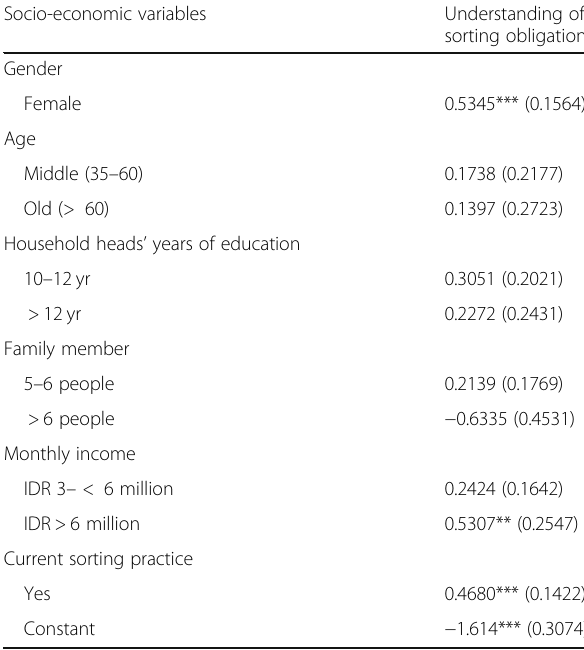
Table 6 Results from the binary logistic regression on understanding of obligation to perform waste